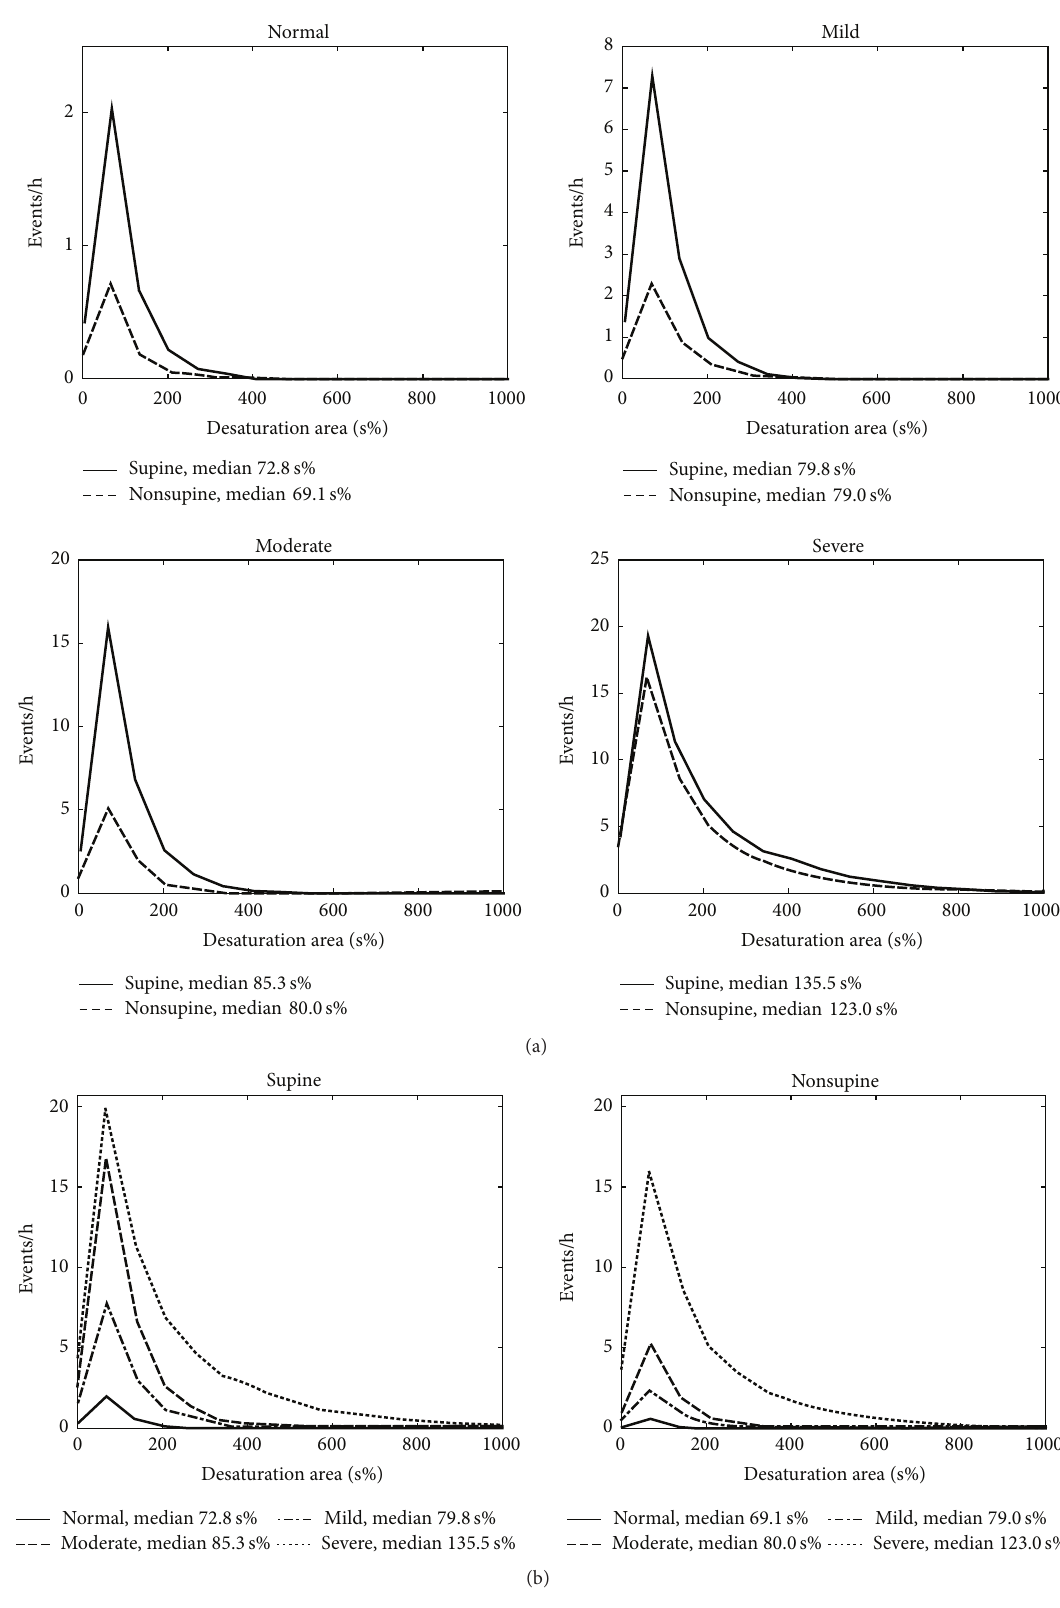
Figure 2: (a) Positional sleeping time adjusted distributions of the areas of individual desaturation events in supine and nonsupine positions in different OSA severity categories and (b) distributions in nonsupine and supine positions as a function of OSA severity. In all OSA severity categories the areas of the desaturation events are larger in the supine position compared to the nonsupine position. Based on mixed model analysis,thedifferencesarestatisticallysignificantinthemoderateandsevereOSAseveritycategories. Themediandesaturationareasincrease along increasing OSA severity in both supine and nonsupine